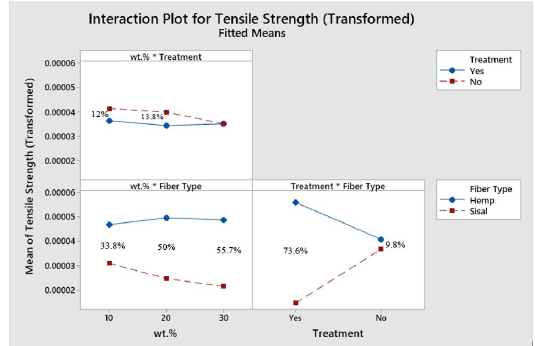
Figure 5. The second-order interaction effect plot for the mean transformed tensile